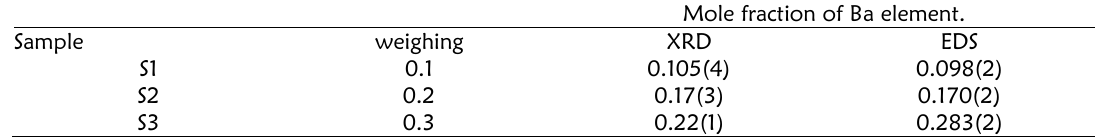
Table 6. The mole fraction of Ba element in S1, S2, and S3 samples result from the conversion of its mass fraction. Mole fraction of Ba element.